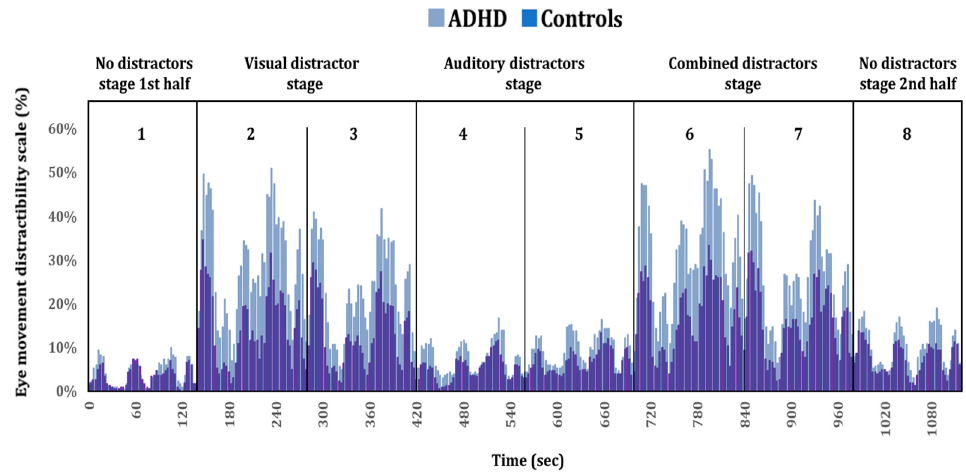
Figure 5. Timeline plot comparing eye movement distractibility scale of ADHD patients and controls. Four distractors stages (non, visual, auditory, and combined) are presented at the top section of the chart, subdivided into blocks one to eight. Each stage includes two consecutive blocks, except for the no distractors stage (blocks 1 and 8).